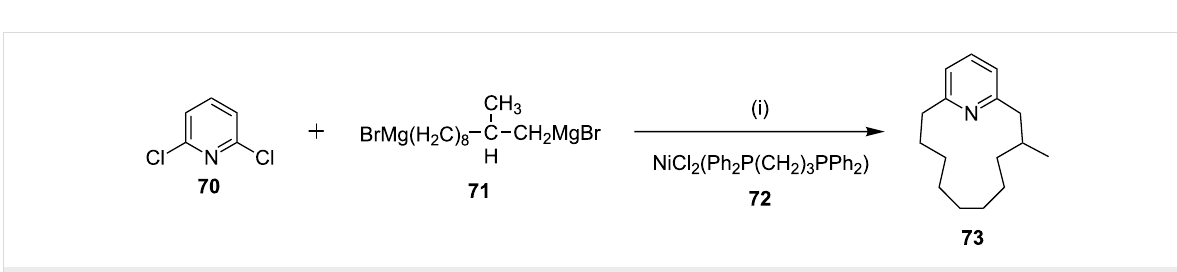
Scheme 11: Synthesis of muscopyridine 73 via Kumada coupling. Reagents and conditions: (i) 72 , THF, ether, 20 h, rt,